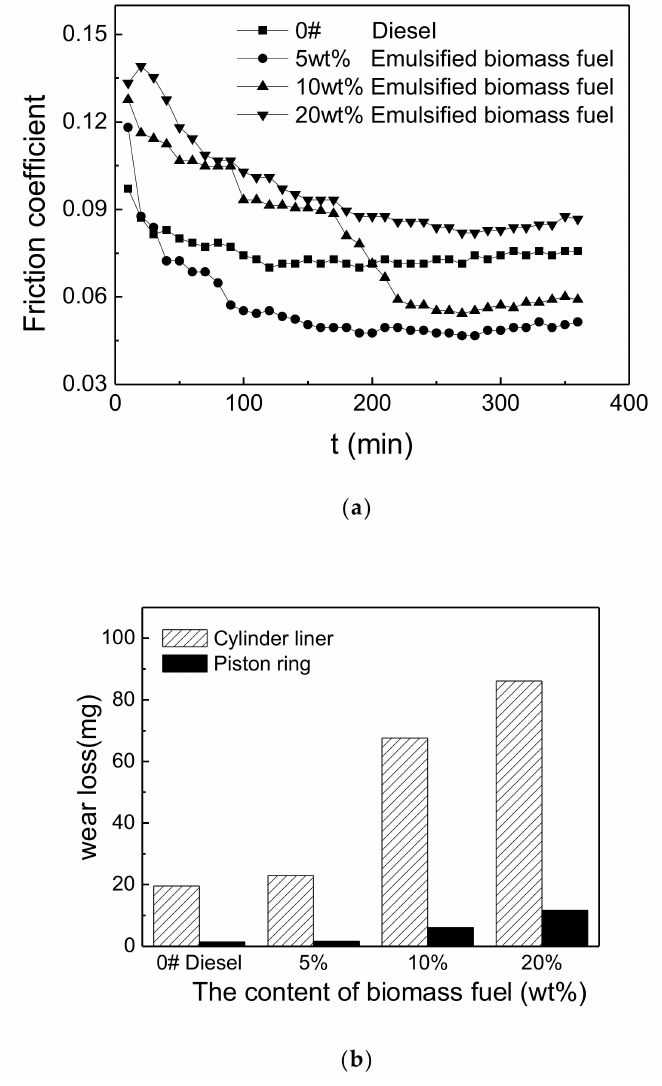
Figure 3. Changes of friction coefficient and wear loss of emulsified biomass fuel with biomass fuel content ( a ) friction coefficient and ( b ) wear